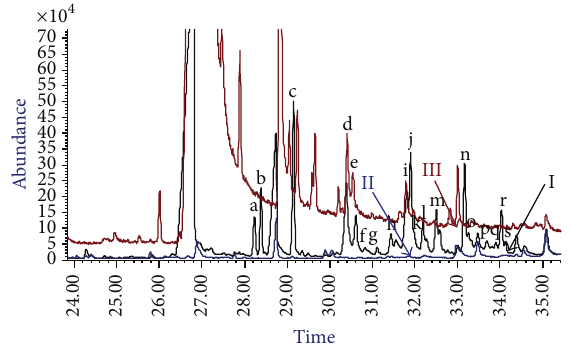
Figure 2: GC-MS detection of DHAA metabolites in suspension- cultured cells of A. annua . (I): suspension-cultured cells with DHAA; (II): suspension-cultured cells without DHAA; (III): media with DHAA but without suspension-cultured